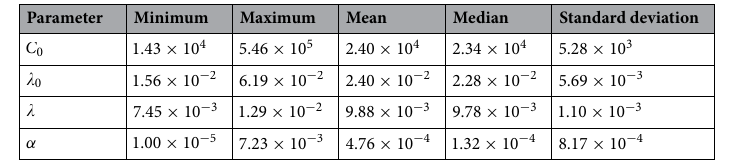
Table 5. Summary statistics for the posterior distributions of the exponential model for the OT-I clonotype.